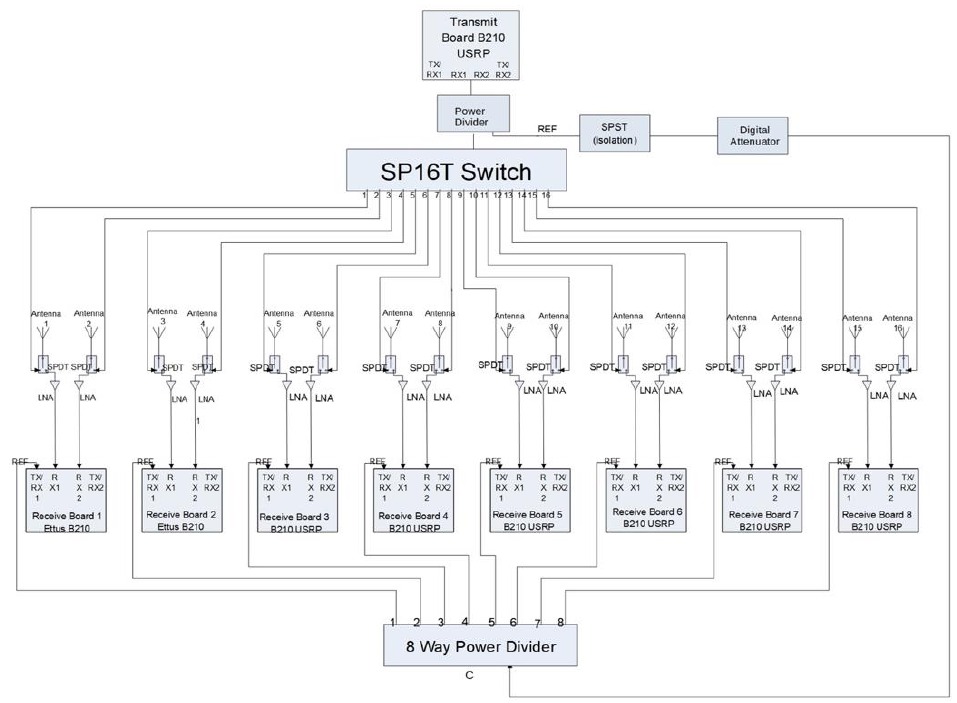
Figure 1. Schematic diagram of the complete system illustrating: ( a ) transmitting B210 board, ( b ) transmitting SP16T switch, ( c ) 16 switch / amplifier modules, ( d ) eight dedicated receive B210s, ( e ) switch module for the reference signal, and ( f ) 1-by-8 power dividers for the reference signal,